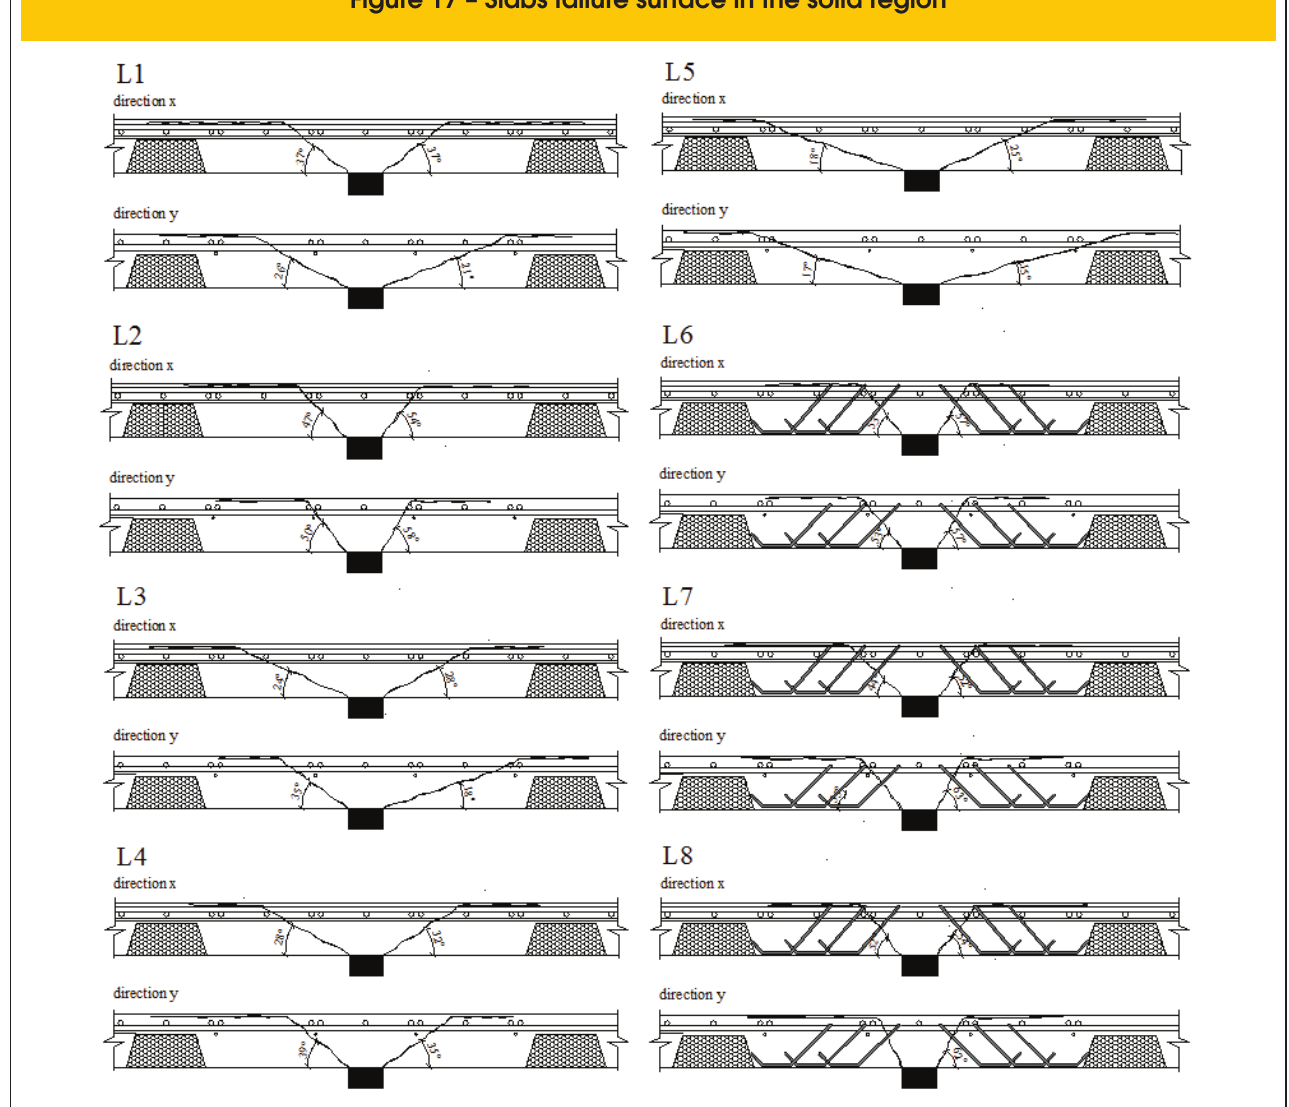
Figure 17 – Slabs failure surface in the solid